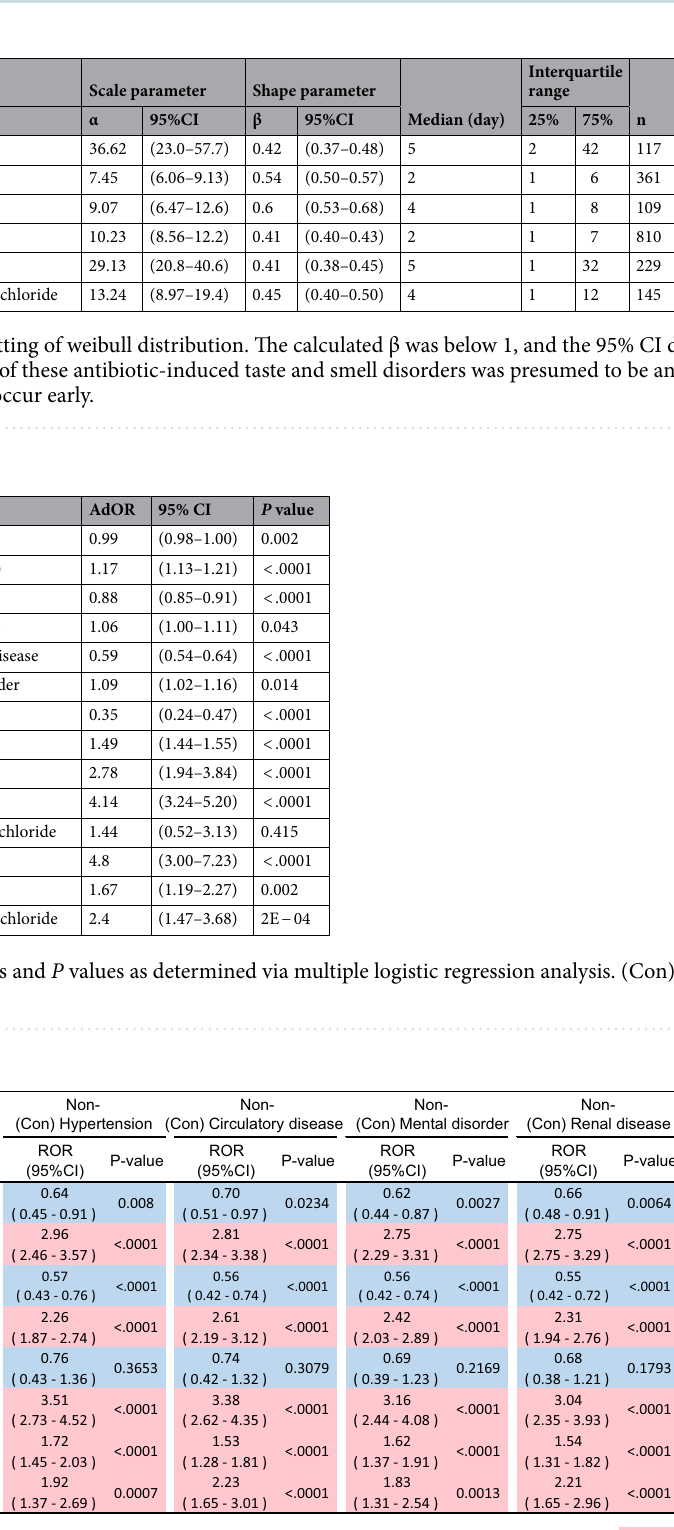
Table 5. ROR of antibiotics that cause taste and smell disorders adjusted for the effects of concomitant disease. A signal was determined to be present if the lower limit of the 95% CI of the recalculated ROR was greater than 1. If a signal was determined to be undetectable after adjustment for confounding factors, the signal intensity of that drug before adjustment was a false signal due to confounding